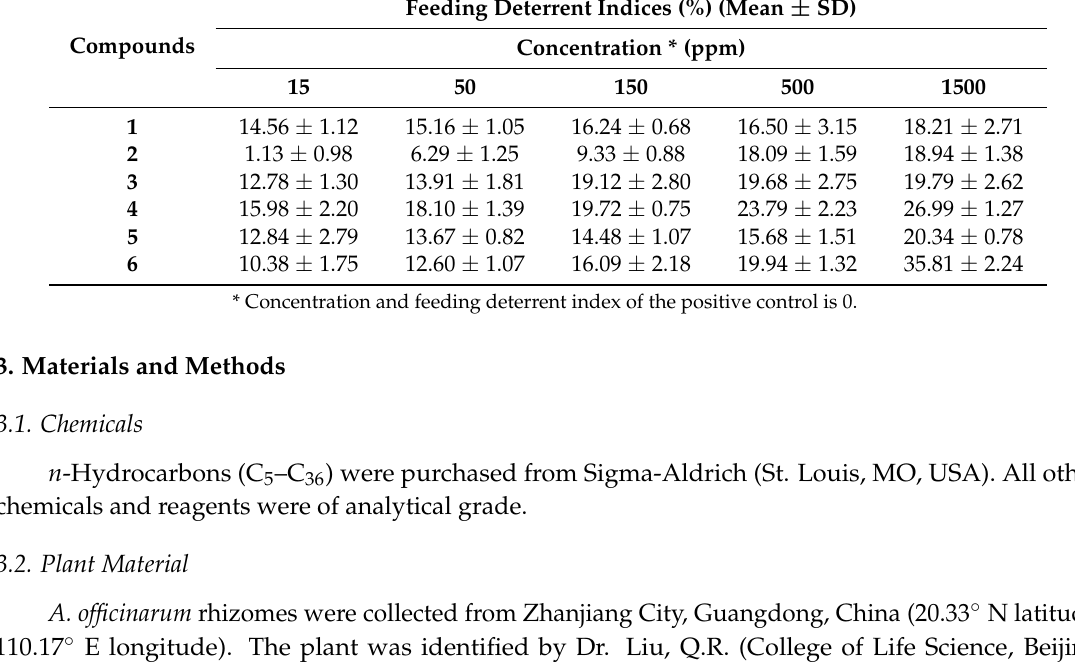
Table 3. Feeding deterrent activity of six compounds isolated from SFE-sample of A. officinarum rhizomes against T. castaneum